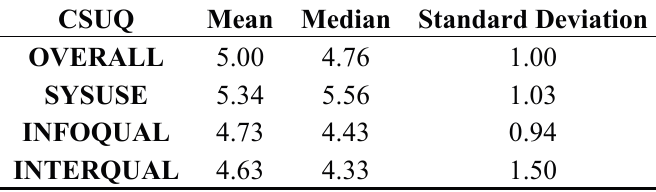
Table 5. Summary of results from the Computer System Usability questionnaire (CSQU). Results are presented in four categories; (OVERALL: all 18 questions), system usefulness (SYSUSE: question 1–8), information quality (INFOQUAL: questions 9–15) and